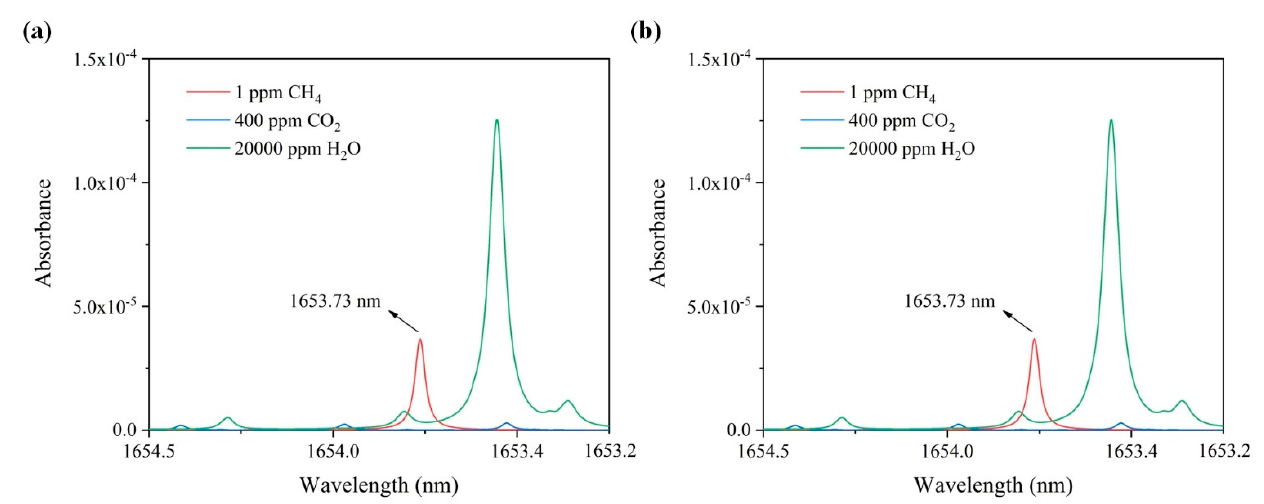
Figure 4. ( a ) Simulated absorption lines of NH 3 and CH 4 around 1512 nm. ( b ) Simulated absorption lines of CH 4 around 1653 nm.